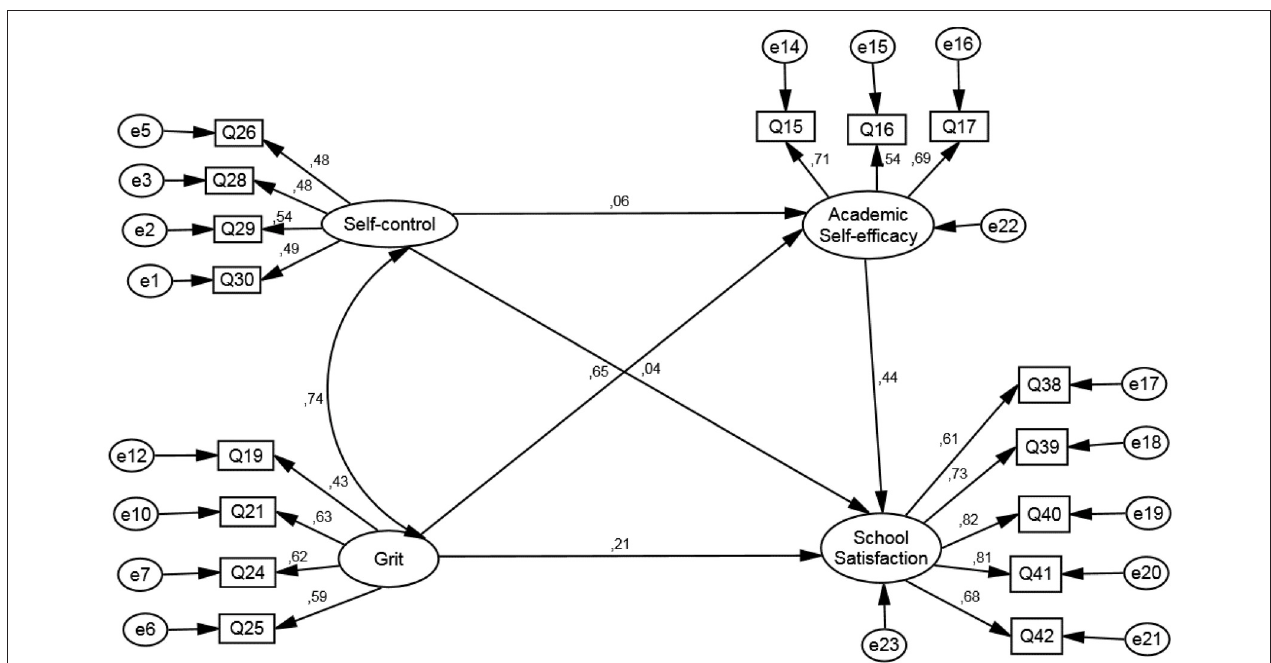
FIGURE 2 | Structural equation model for secondary students.